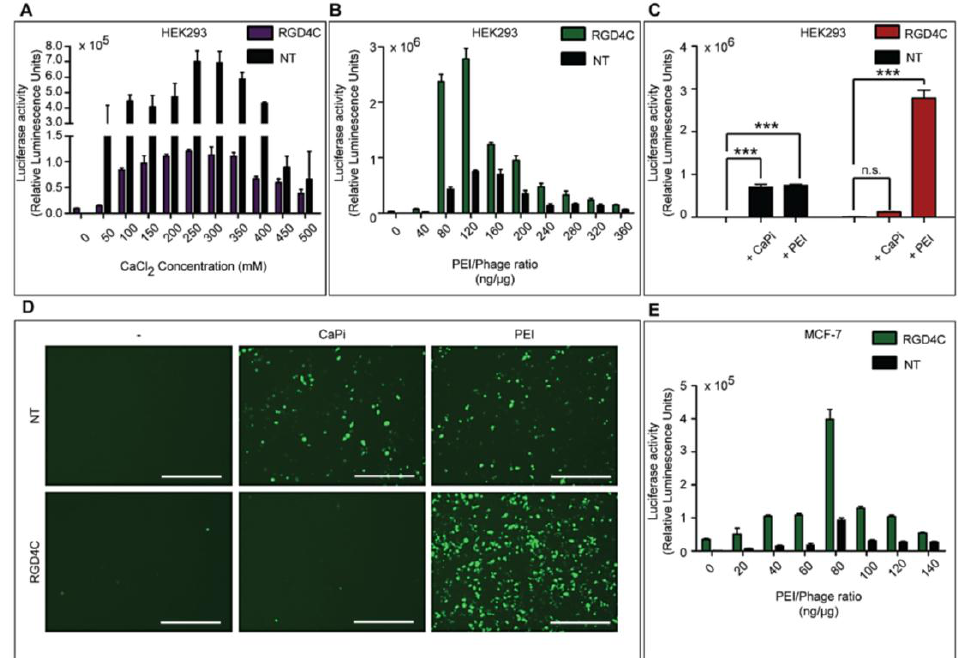
Figure 6. Combination of chemical and genetic modification boosts phage-mediated gene transfer. HEK293 cells were treated with targeted RGD4C-phage vectors or non-targeted-phage vectors, carrying the Luc or GFP reporter genes, premixed with CaPi or PEI. ( A ) Optimization of CaCl 2 concentrations with RGD4C-phage vectors in HEK293 cells; ( B ) Optimization of PEI concentrations with RGD4C-phage vectors in HEK293 cells; ( C ) Comparison of transduction efficiency between RGD4C-phage and non-targeted (NT) phage vectors premixed with either CaPi or PEI; ( D ) Fluorescent imaging of HEK293 cells treated with vectors carrying the GFP reporter gene to show comparison between non-targeted, NT, and targeted phage, RGD4C, complexed with either CaPi or PEI. Scale bars = 500 µm; ( E ) Optimization of PEI concentrations with RGD4C and NT phage vectors in MCF-7 cells. Asterisks are definedas: *** p < 0.001 and n.s., non-significant.